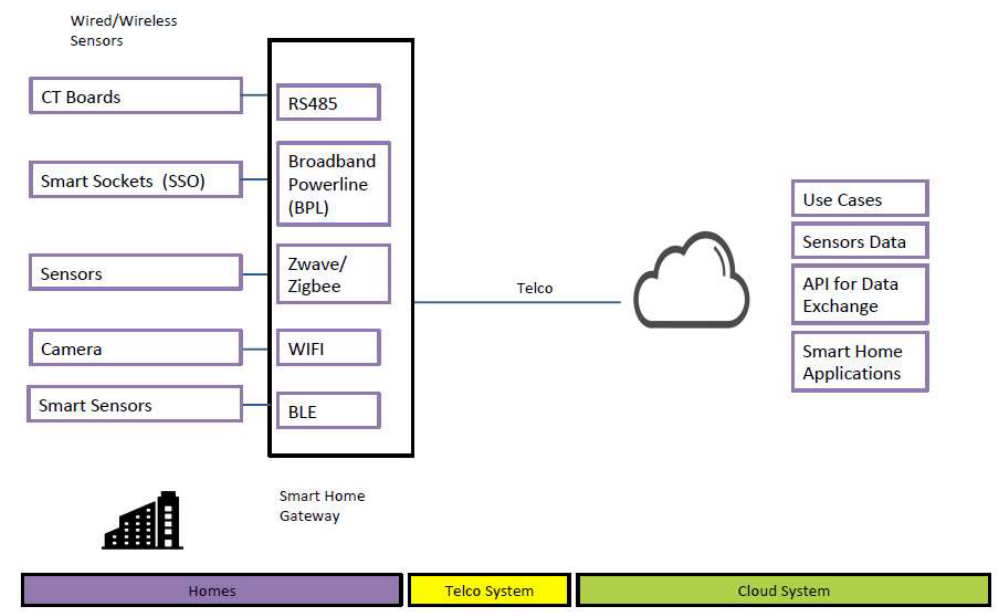
Figure 3. Connectivity of sensors within the